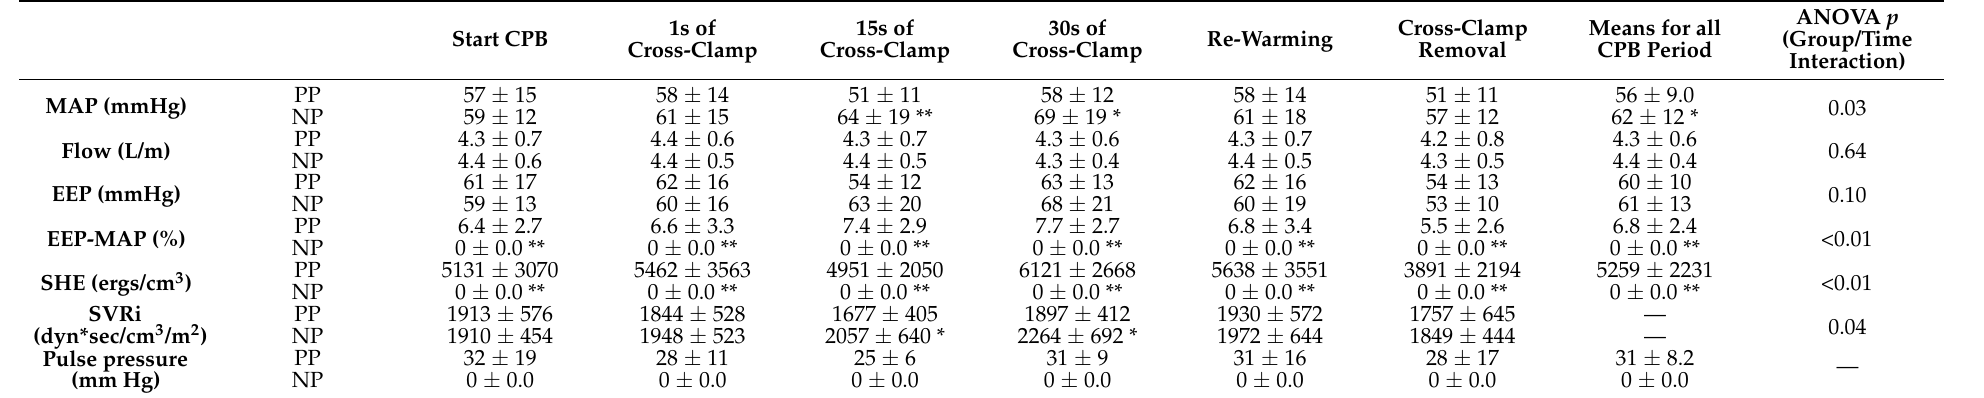
Table 2. Hemodynamic profile during cardiopulmonary bypass.